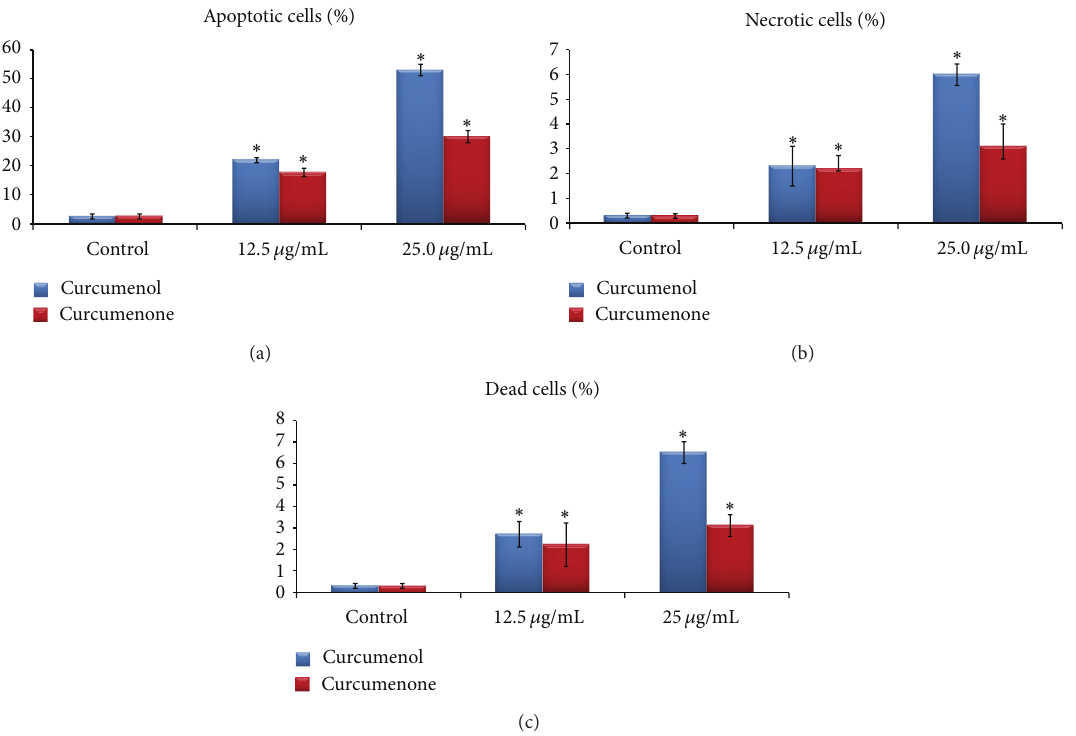
Figure 5: Apoptotic index and percentage of necrotic cells. Values expressed are means ± standard deviation (s.d.) of triplicate measurements. The asterisks ( ∗ ) denote significant differences between groups (𝑃 < 0.05)